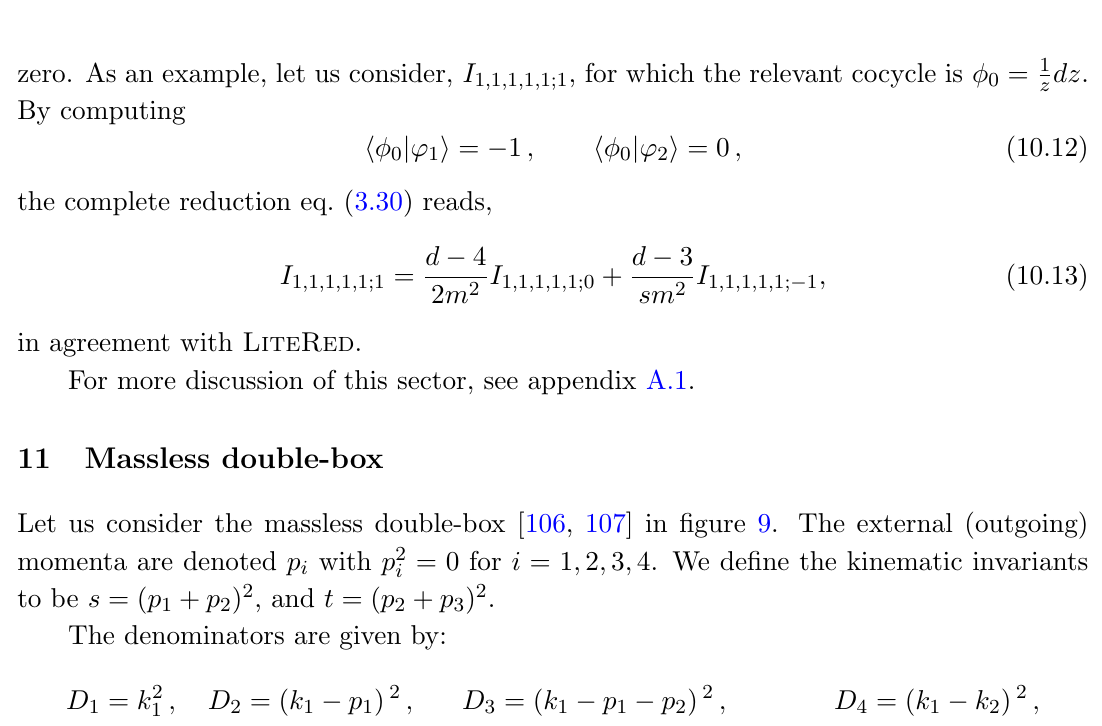
Figure 9. Massless